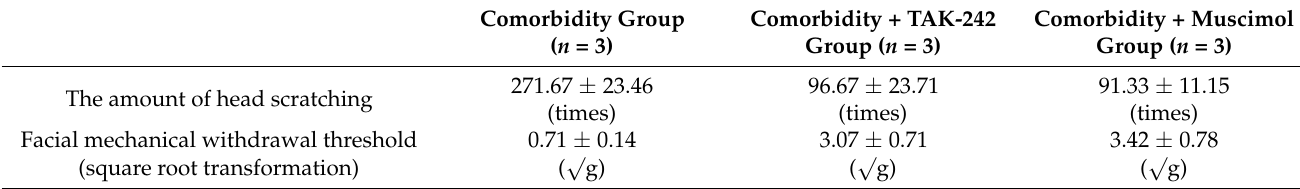
Table 5. Comparison of the number of head scratching and facial mechanical withdrawal threshold in different groups of rats after drug